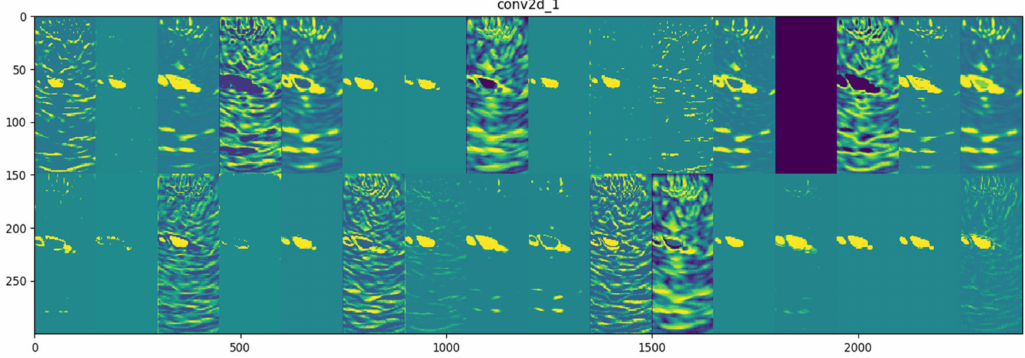
Figure 13. Visualization of 2 × 16 filters from the first convolutional